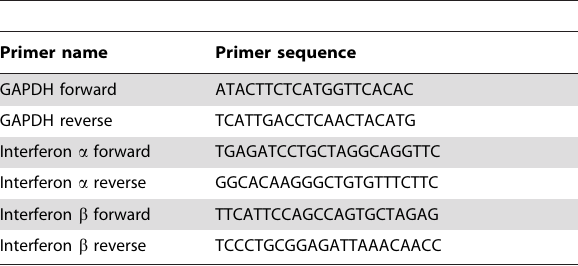
Table 2. Primers used for quantitative PCR analysis of gene transcription in cloned P. alecto